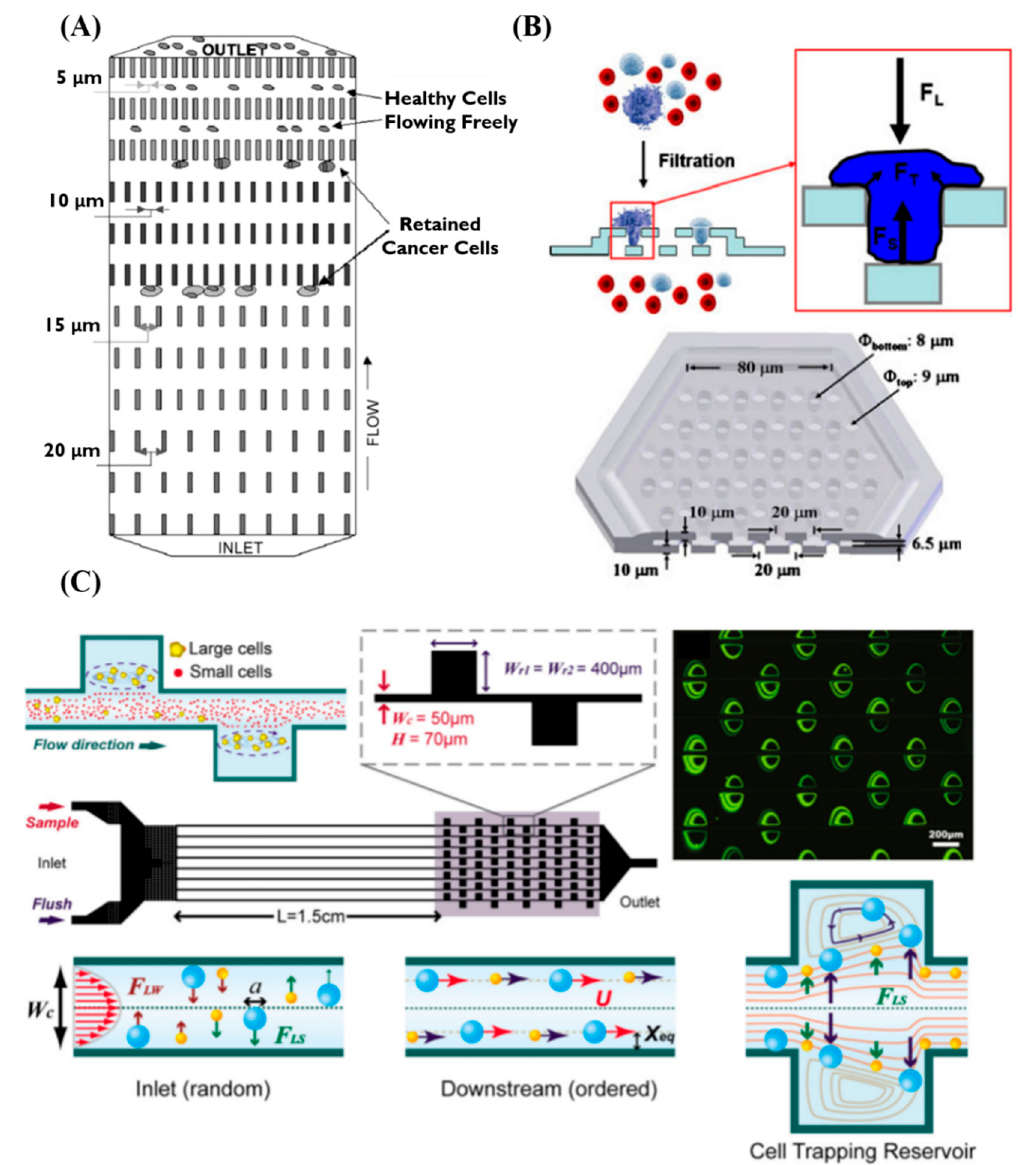
Figure 1. The sorting of CTCs are based on size. ( A ) The schematic device based on difference size of channel gap widths (20, 15, 10, and 5 µ m) and channel depths (20, 15, 10, or 5 µ m) separate cells [50]. ( B ) The schematic device of filtration process and forces on a trapped cell and a single hexagonal-shaped microfilter patch [51]. ( C ) Multiple microscale laminar vortices device and working principle were used for size-based cell isolation [52]. By adopting this technology, a High Throughput Vortex Chip (Vortex HT) [53] was developed. CTCs in whole-blood samples from advanced metastatic castration-resistant prostate cancer were isolated rapidly in this chip, which demonstrated an optimized processing speed (8 mL/min) with high purify and efficiency.